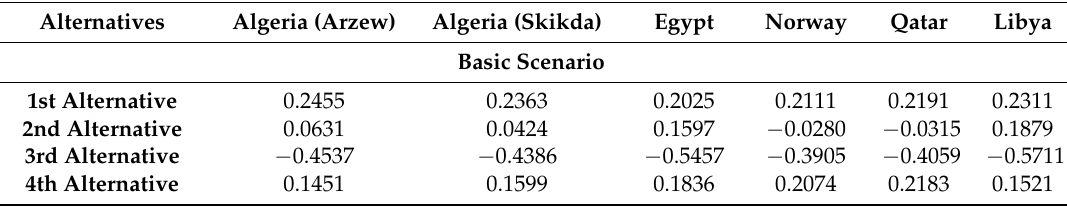
Table A2. The values Φ from the sensitivity